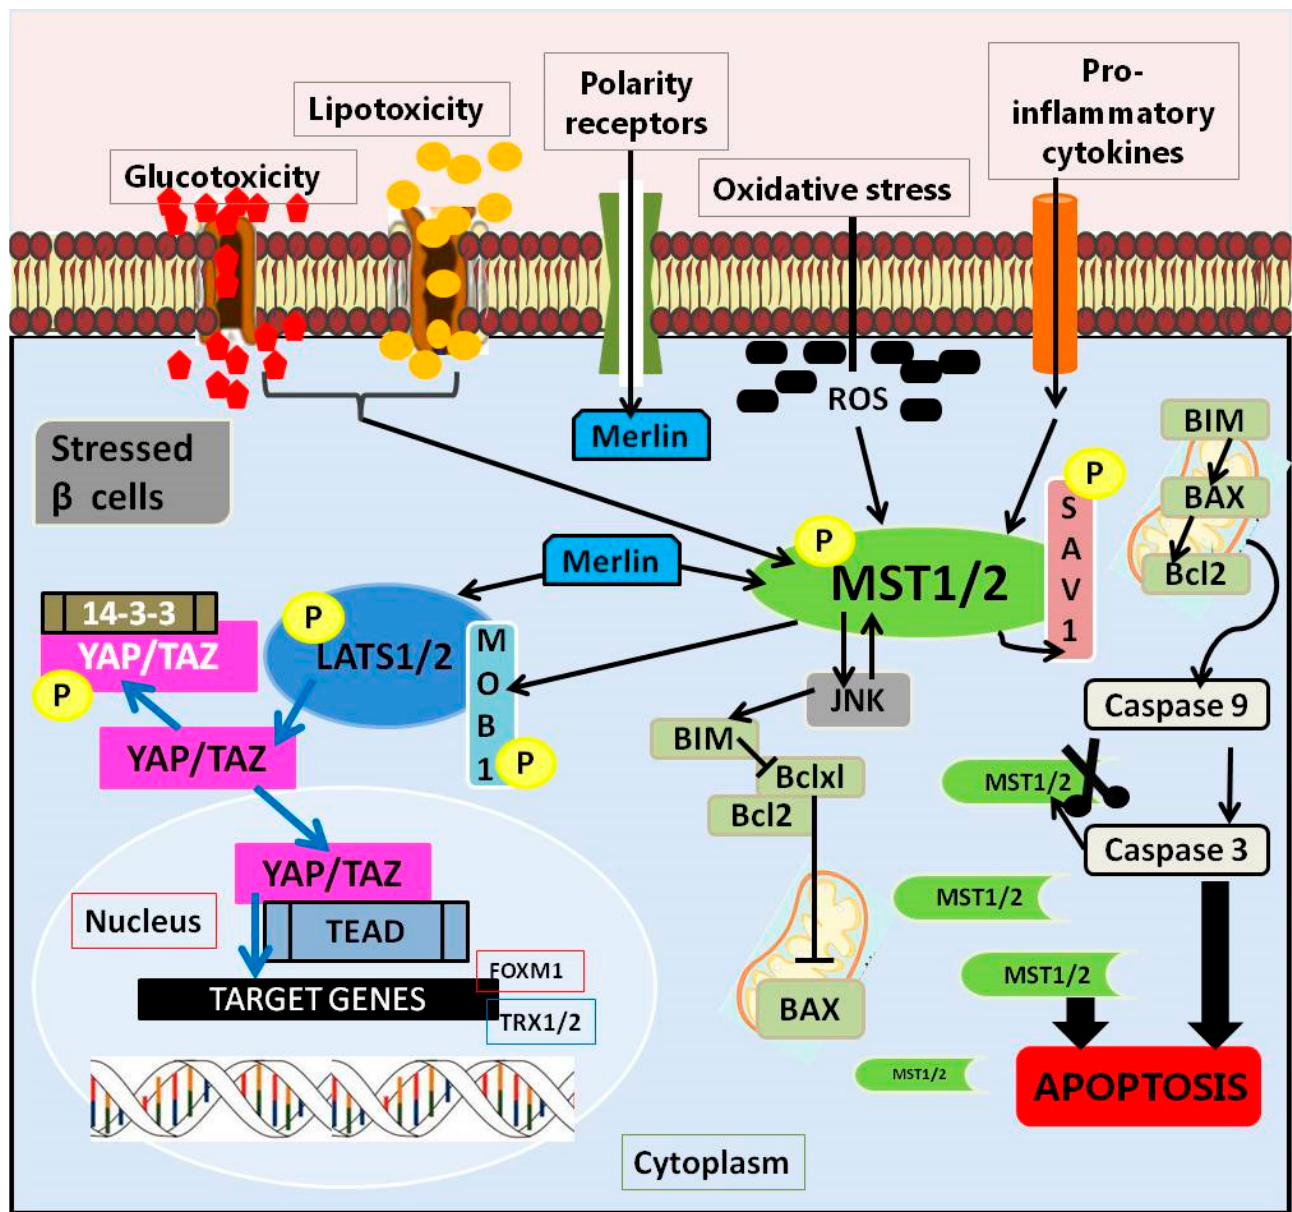
Figure 1. The Hippo pathway in pancreatic β cells.